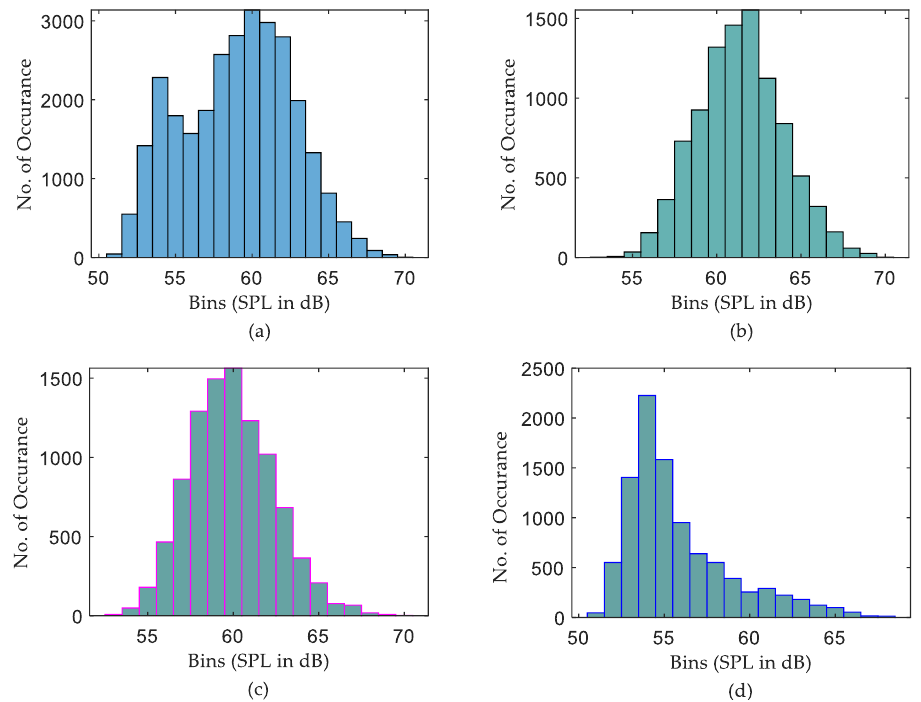
Figure 12. Histogram calculation of ICU1 data over 20 days, ( a ) distribution of SPLs over the entire period, ( b ) distribution of SPLs over daytime, ( c ) distribution of SPLs over evening, and ( d ) distribution of SPLs over night.